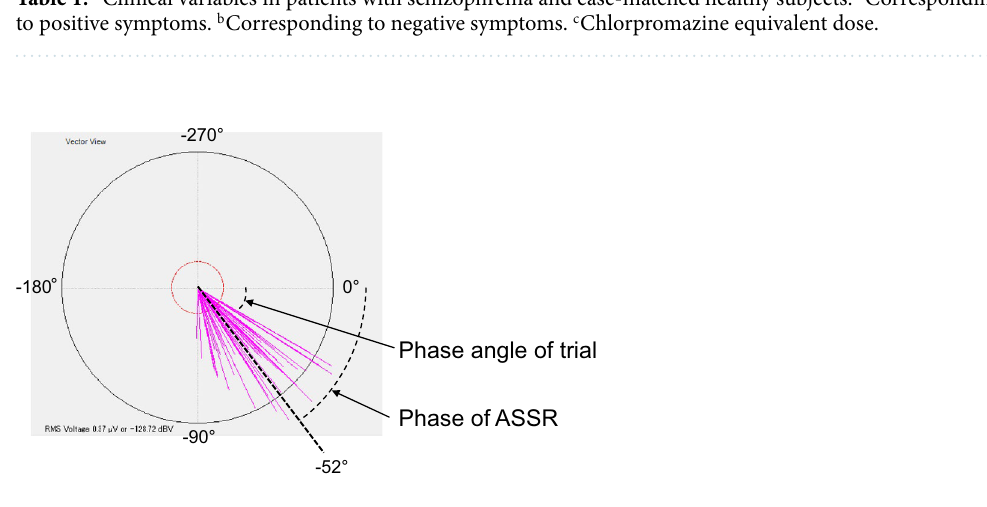
Figure 4. A healthy subject’s result of the basic 40-Hz ASSR in the evoked response audiometry (ERA) system. Each pink vector in the diagram displays the phase angle and the response amplitude of each trial. The phase angle (°) of each vector represents the time-lag from the periodic tone stimuli to the neural response of each trial at the modulation frequency of 40 Hz. The mean of the phase angles of 64 trials was provided as the phase of ASSR in the ERA system (the illustrated straight dotted line, − 52° in this case). The length of each vector represents the response amplitude of each trial. The red inner and the black outer circles represent the lines of 0.1 μV and 0.5 μV,